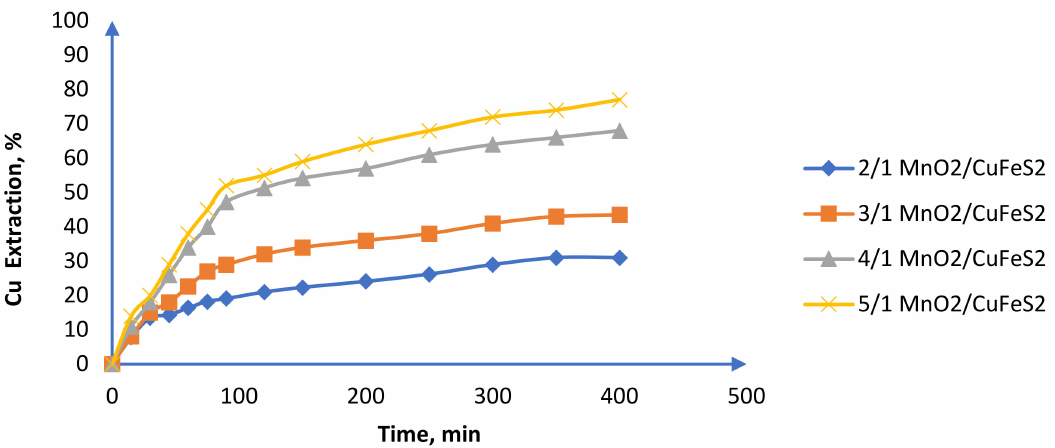
Figure 9. Effect of the MnO 2 /CuFeS 2 ratio on Cu extraction (25 ◦ C, CuFeS 2 size: − 47 + 38 m, MnO 2 size: − 75 + 53 m, 1 mol/L H 2 SO 4 and 39.16 g/L of chloride) [5].